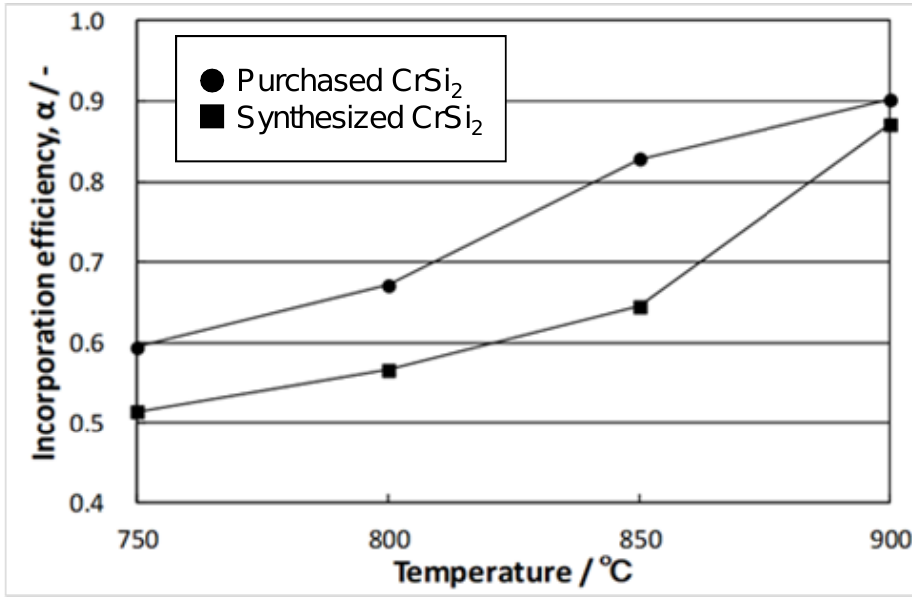
Figure 8. Dependence of incorporation efficiency on melt temperature.